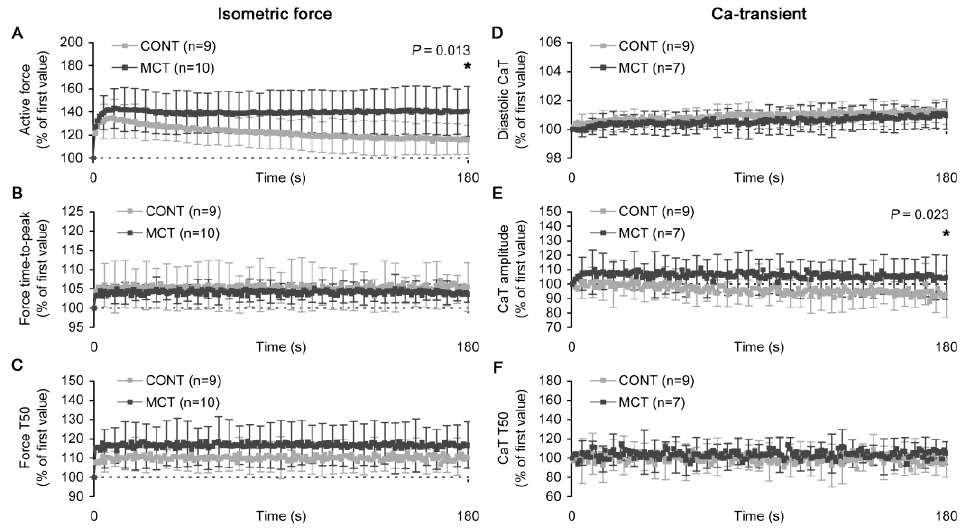
Figure 7. The slow changes in the characteristics of individual isometric force twitches (left panels) and Ca transient (CaT, right panels) measured in the right atrial strip of control (CONT) and monocrotaline-treated (MCT) rats after rapid stretch (during 100 ms) of a strip from 85% to 95% L MAX . ( A ) The amplitude of active force. ( B ) The time-to-peak of active force. ( C ) The time of relaxation from peak force to 50% of its amplitude ( T 50 ). ( D ) Ca transient diastolic level. ( E ) Ca transient amplitude. ( F ) The time of Ca transient decay from peak to 50% of its amplitude ( T 50 ). All values are shown as a % of the value in the first twitch after stretch; dotted horizontal lines represent a 100% value (no change relatively to the first twitch). The number of atrial strips is indicated in the legends. Data shown as mean ± S.D. * — the difference between CONT and MCT at the end of the slow changes is significant at p < 0.05. All measurements were done at 30 °C and a 2 Hz pacing rate.